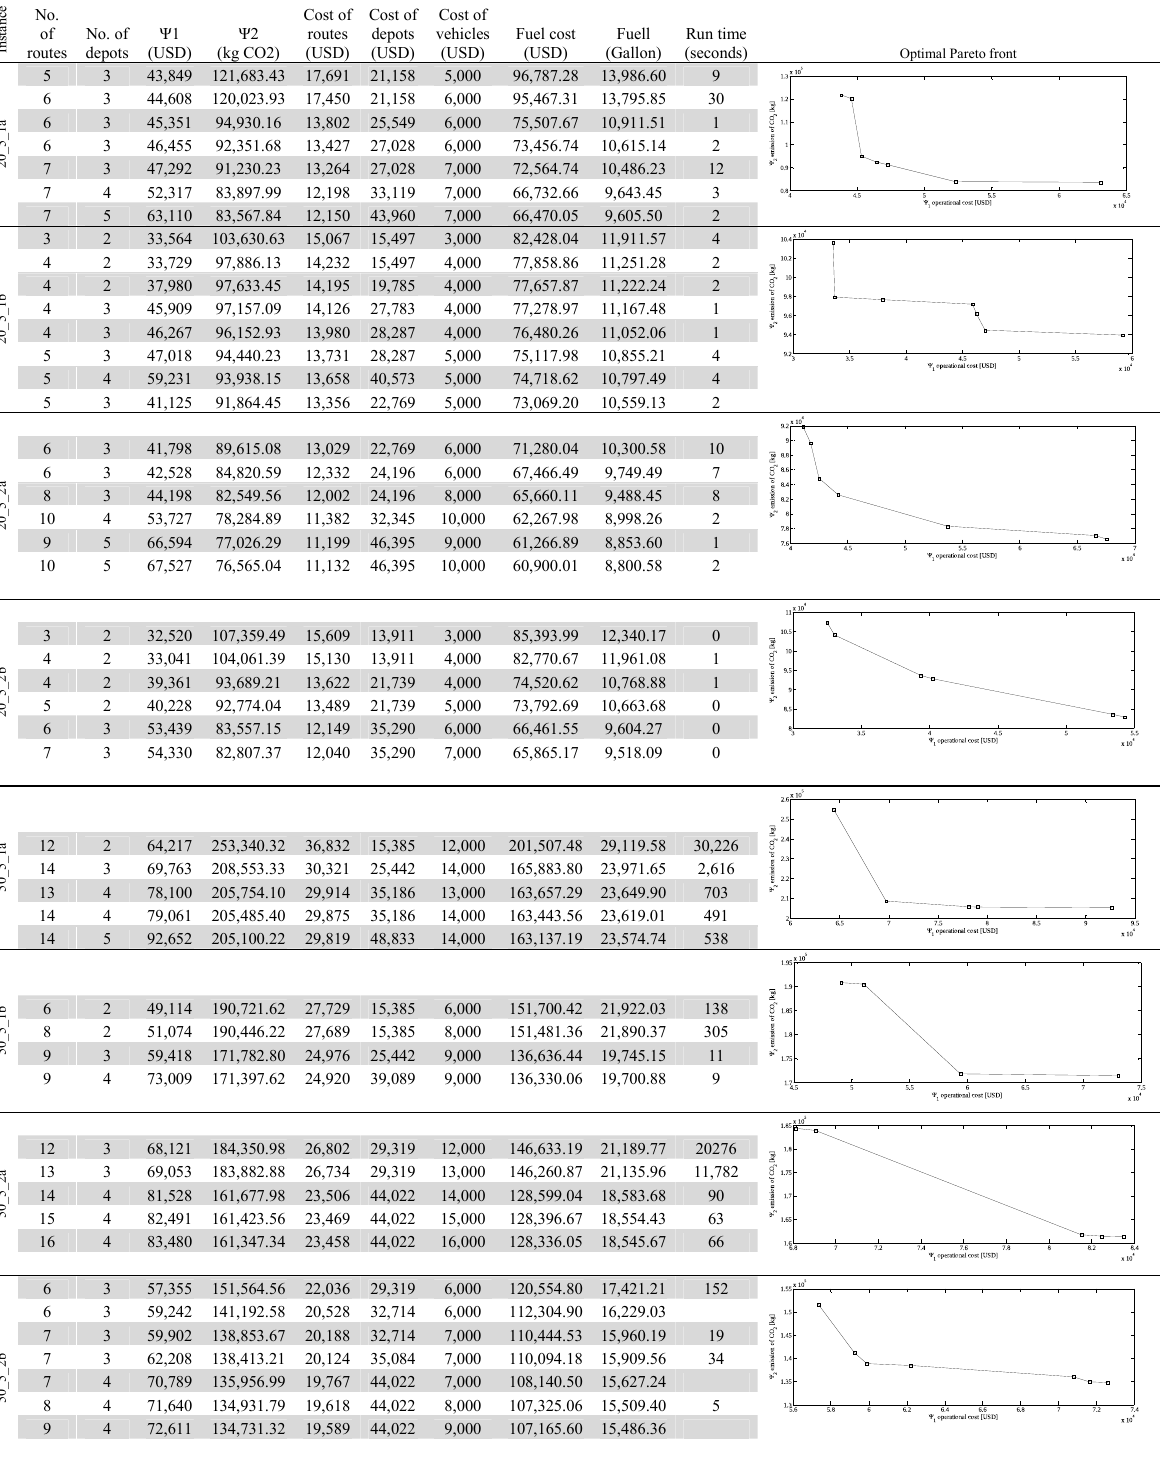
Computational results for instances used by Prins et al.